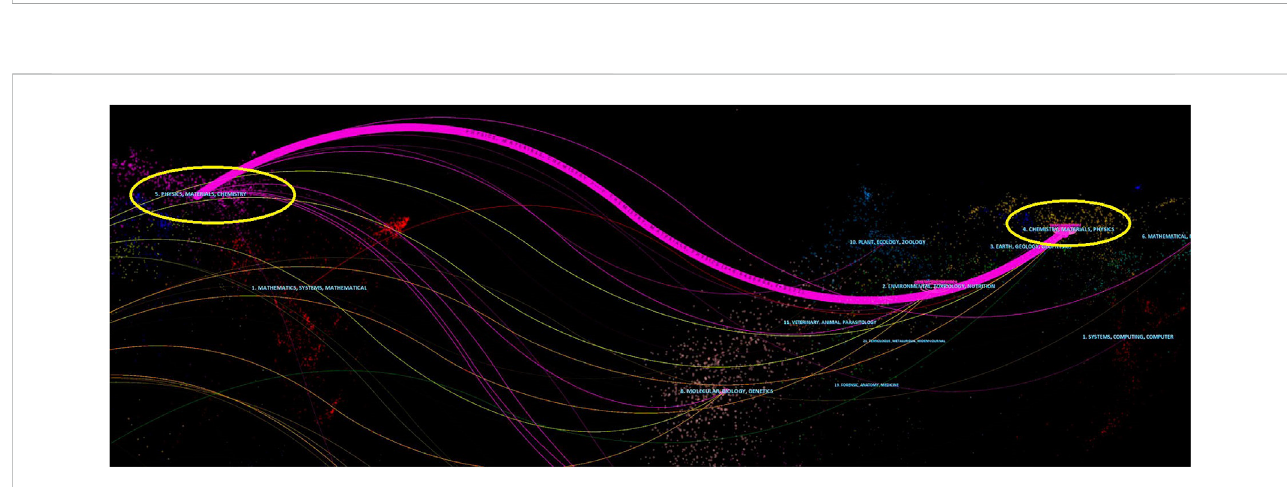
FIGURE 6 Part of dual-map overlay for journals related to the applications of NHs for drug